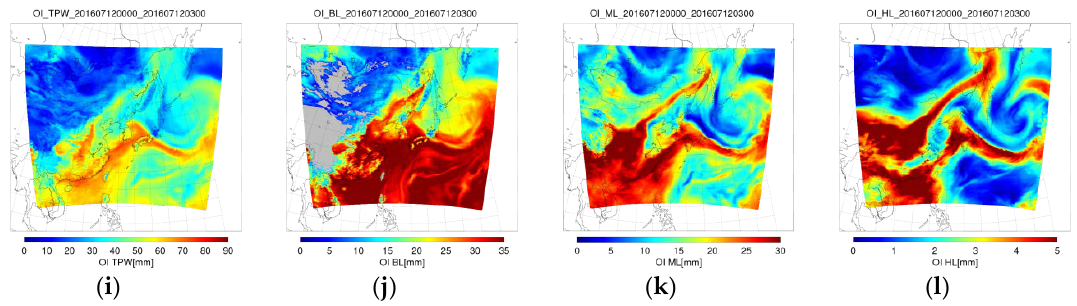
Figure 5. For OI time period of 12 July 2016 00:00–03:00 UTC, ( a – d ) are background fields for four PW (TPW, BL, ML, and HL); ( e – h ) are observation data for four PW; and ( i – l ) are four OI PW fields.